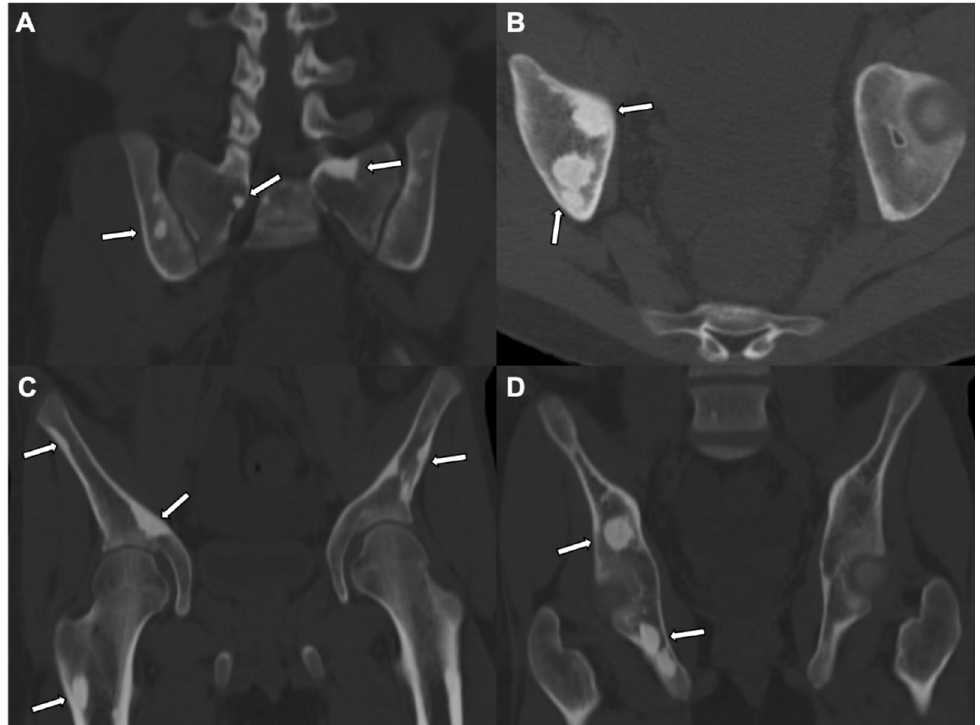
Figure 3. Osteopoikilosis: A CT pelvis, in coronal ( A , C , D ) and axial ( B ) views, of bone windows in a 17-year-old patient shows scattered, rounded, or well defined intramedullary sclerotic foci in bilateral iliac bones, bilateral sacral promontories, the right superior pubic ramus, ischium, and femur subtrochanteric proximal femoral shaft (white arrows), suggesting benign hereditary etiology such as osteopoikilosis.